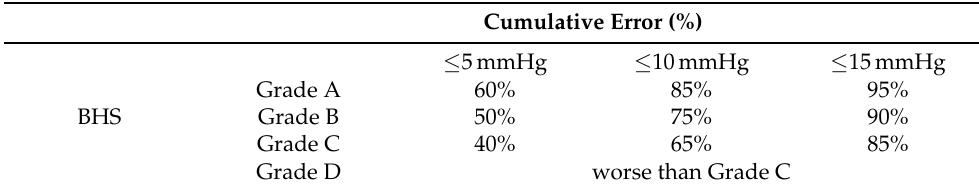
Table 7. Characterization of BP measuring devices based on their cumulative error